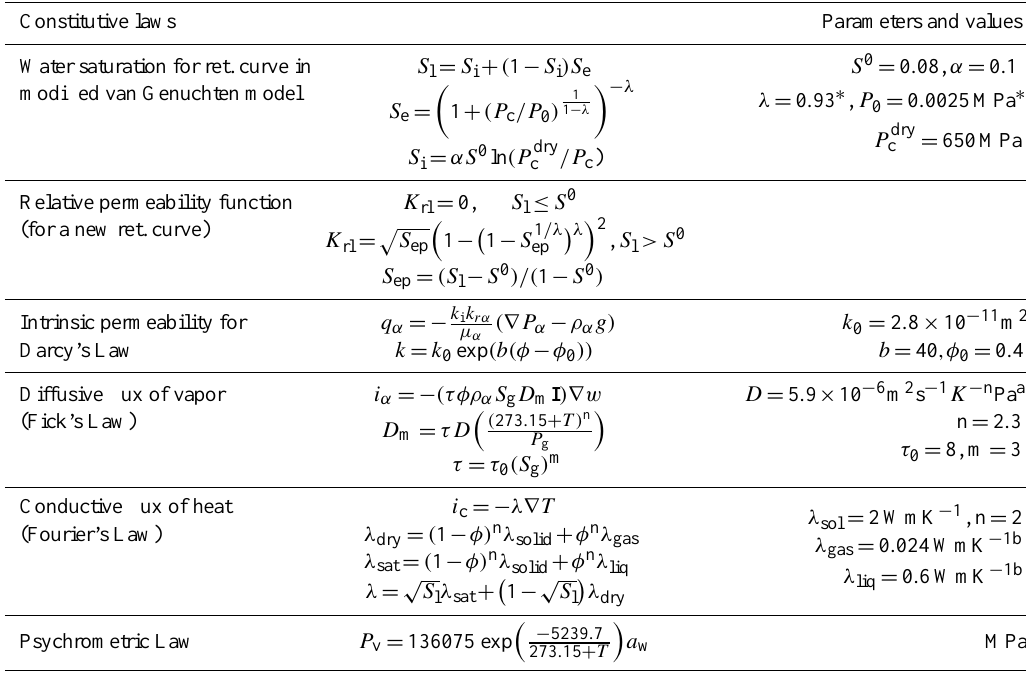
Table 1. Constitutive laws, parameters and values used in the numerical model. Constitutive laws Parameters and values Water saturation for ret. curve in modified van Genuchten model